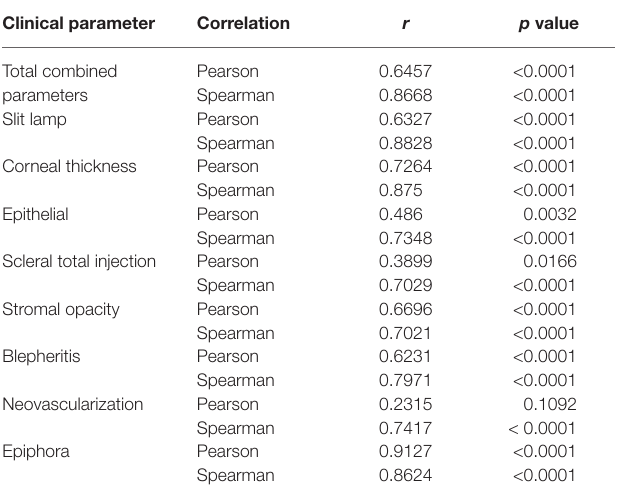
TABLE 1 | Spearman’s and Pearson’s correlation coefficients, including r and p values of each clinical disease assessment compared to AH Serotonin Levels from Figure 9